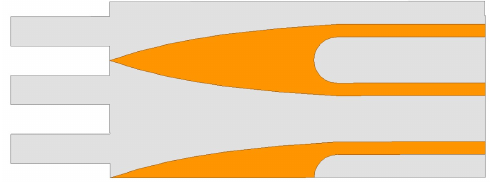
FIGURE 6. The innovative Triple Finline, complete with QWTs.